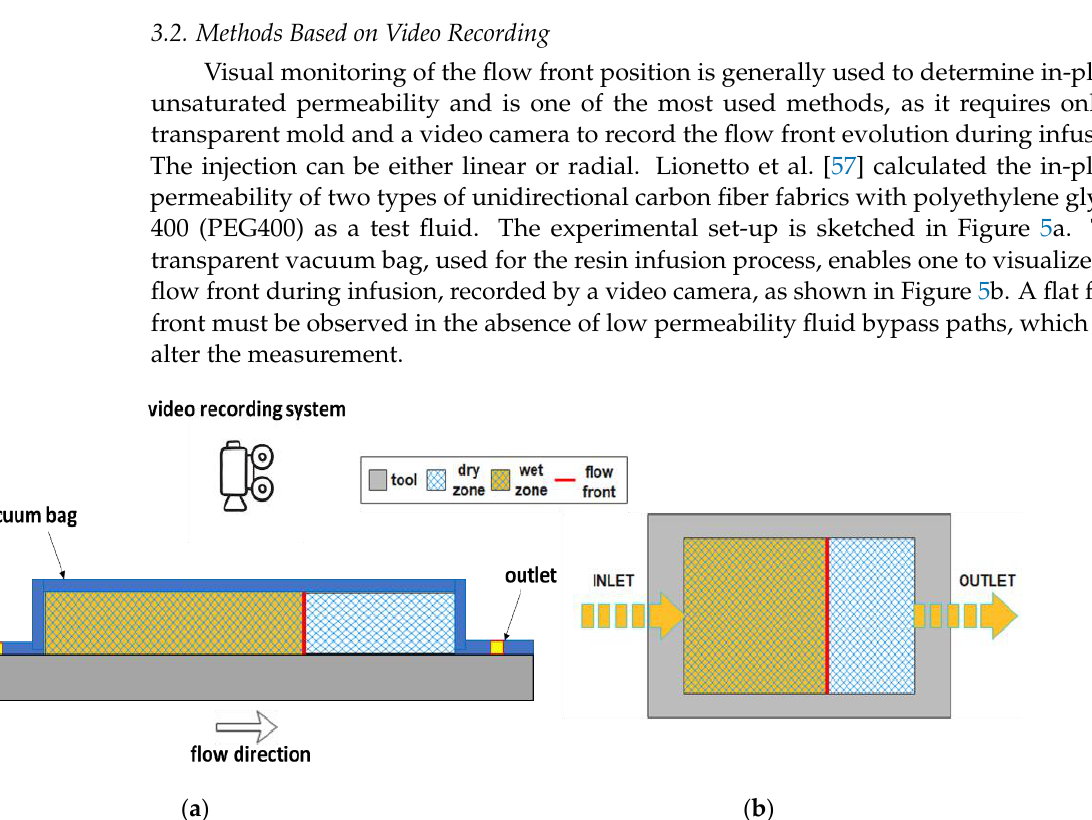
Figure 4. Schematic cross-section of experimental set-up for air flow measurement ([56], Copyright (2022) with permission from Elsevier).